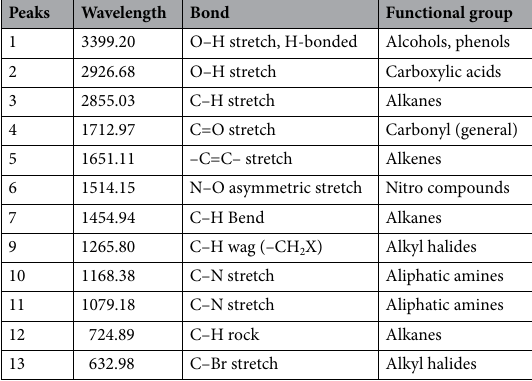
Table 9. FT-IR analysis of flowers of Dodonaea Viscosa.